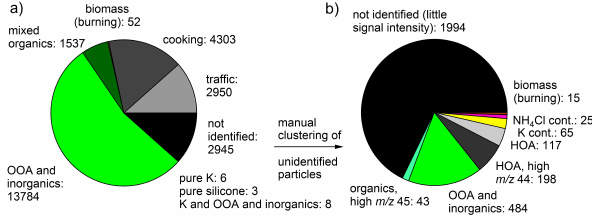
Fig. 4. Application of the classification algorithm on an ambient dataset. Cont.: